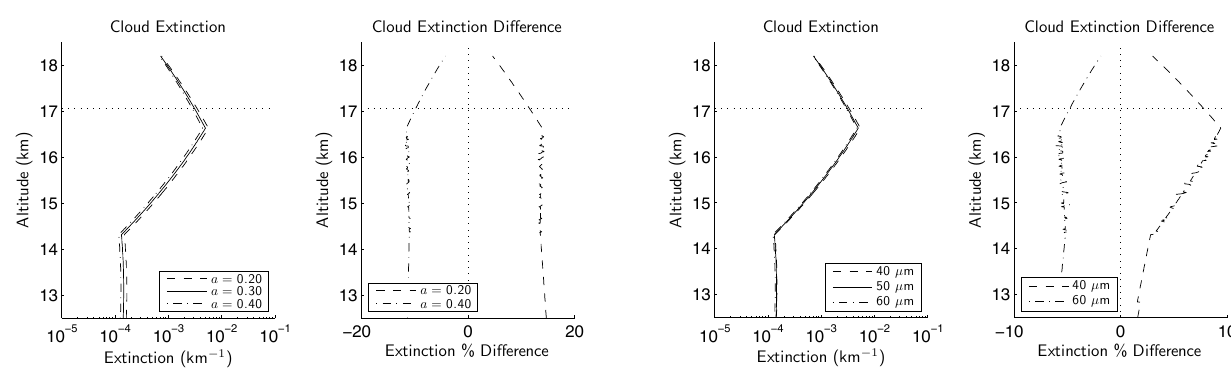
Fig. 14: Retrieved cirrus extinction for varying surface albedo, scan 47939020.